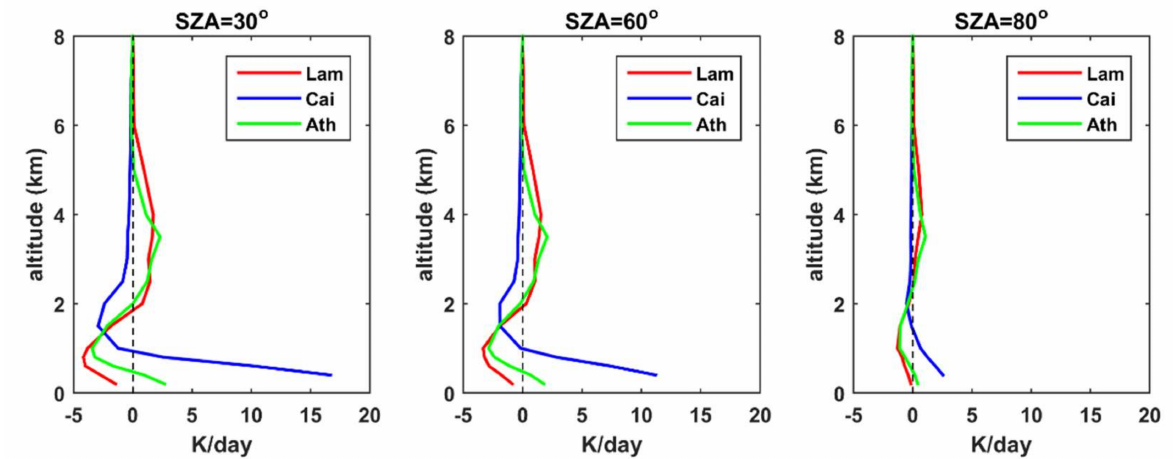
Figure 15. Change (in K/day) in the SW irradiance HR (realistic—default) in the first 8 km of the atmosphere due to the use of the LIVAS profiles instead of the default libRadtran profile for AOD = 1. Results for the three sites and for SZA = 30 ◦ , 60 ◦ , and 80 ◦ are presented in Appendix A. Despite the very high AOD and the significant differences between the LIVAS and the default extinction coefficient profiles, differences in the GI at the BOA were small for the SW irradiance and for each of the four spectral regions (Figure 16). For SW, differences ranged from 0% (over Cairo) to 3% (over Lampedusa). For SZA = 80 ◦ , differences in the NIR region became larger ( − 4% for Cairo and +8% for Lampedusa). At the TOA, differences were generally larger relative to the BOA (between ± 10%) for individual spectral regions (Figure 17), but they were practically zero for the SW irradiance.